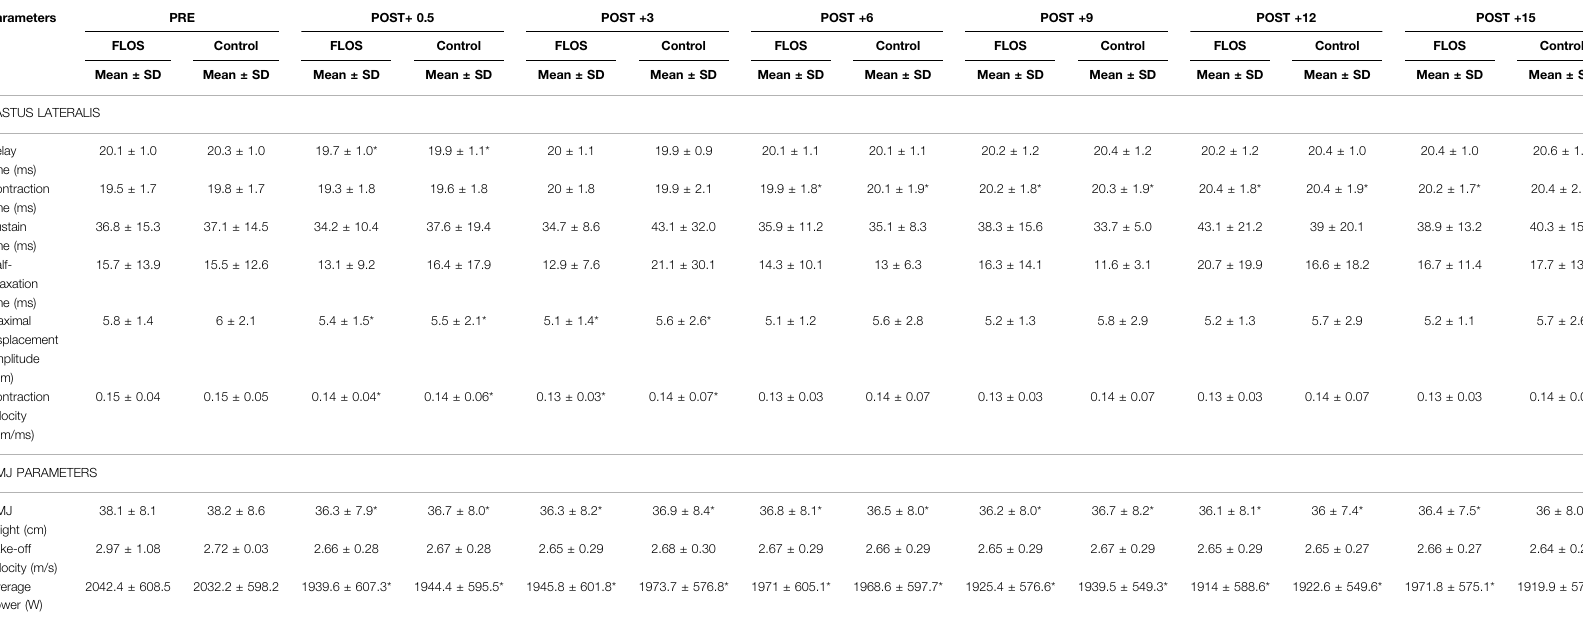
CMJ — countermovement jump; FLOS — experimental group; signi fi cantly different compared to PRE